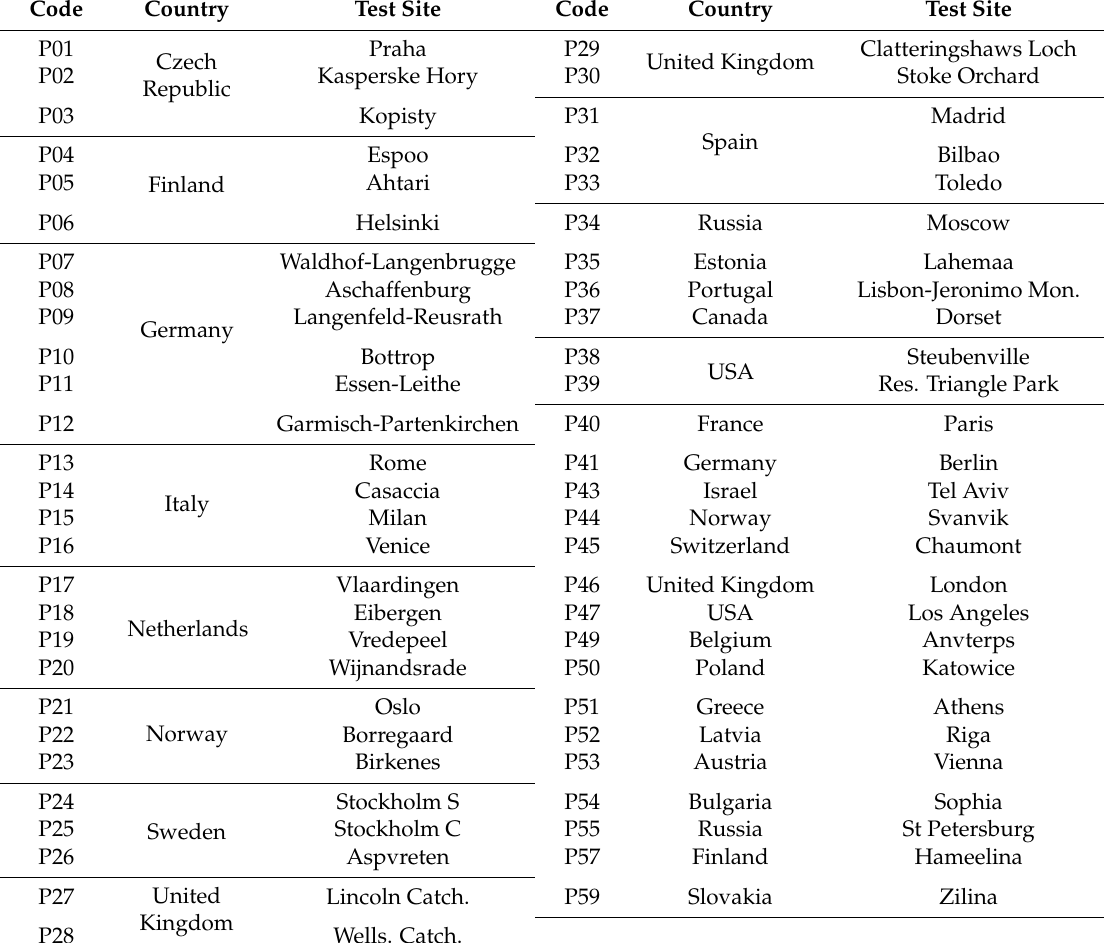
Table 1. Atmospheric corrosion test sites included in the ICP/UNECE Programme.